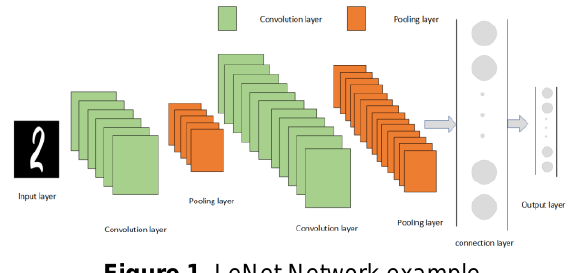
Figure 1. LeNet Network example